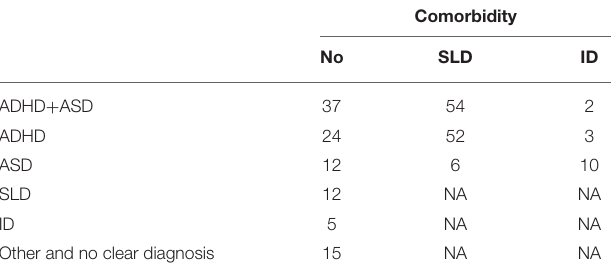
TABLE 2 | Diagnosis of children